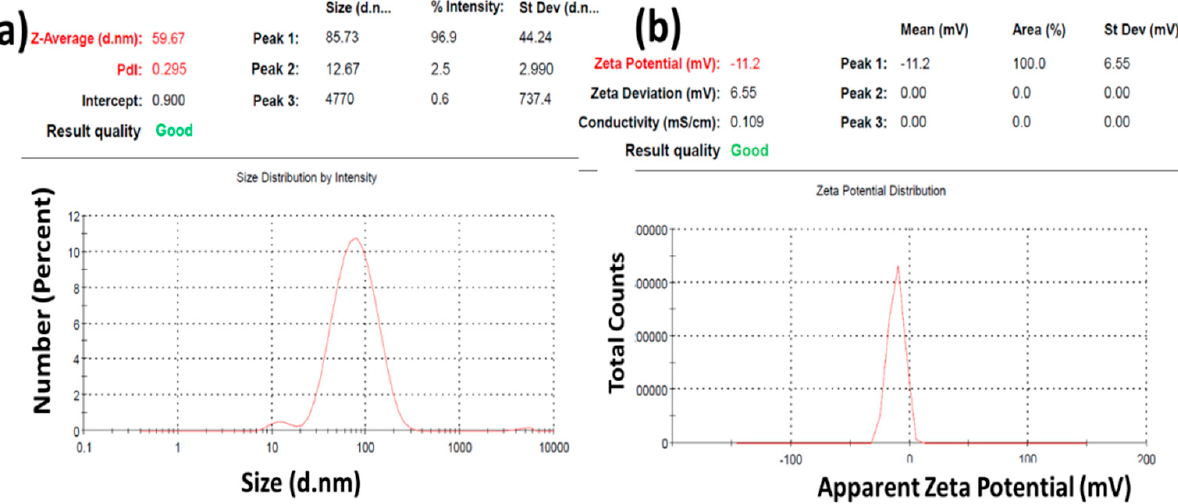
Table 1. Physicochemical characteristics of rutin-SNPs